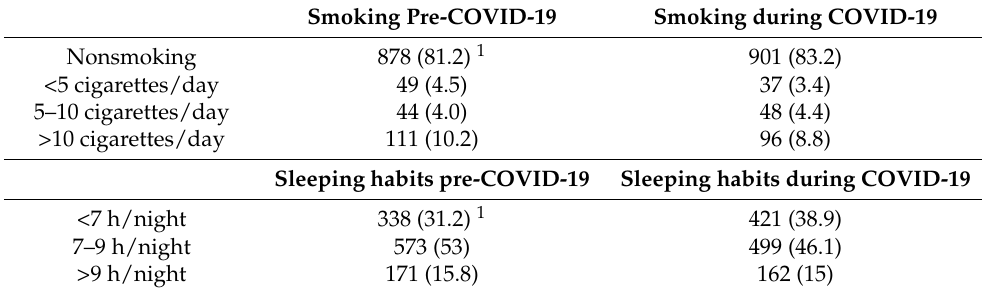
Table 4. Changes in smoking status and sleeping habits before and during the COVID-19